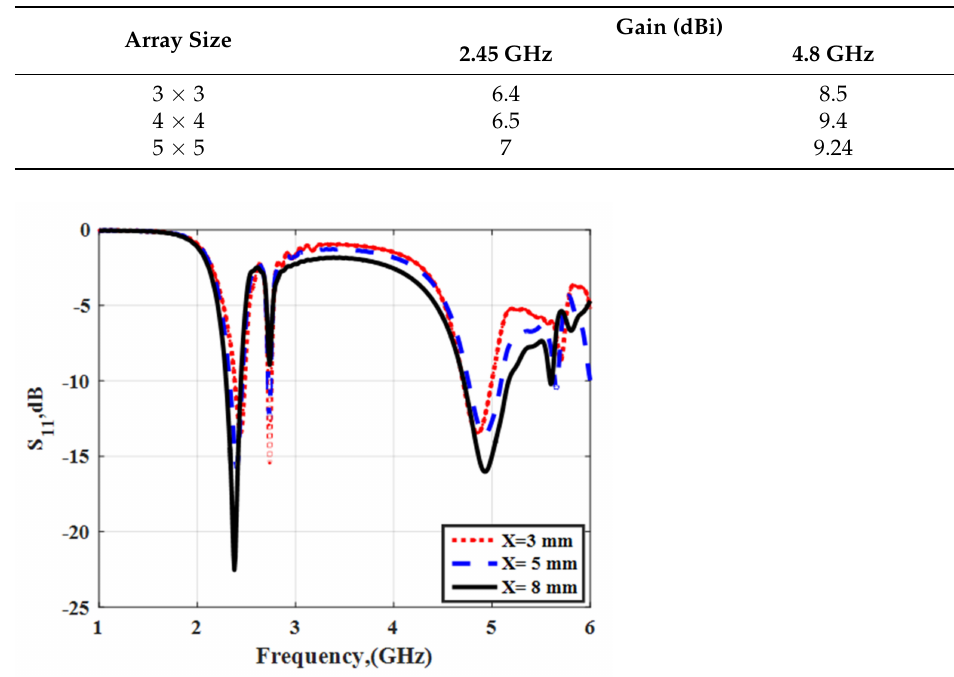
Table 1. The effect of the cell size on the antenna gain.